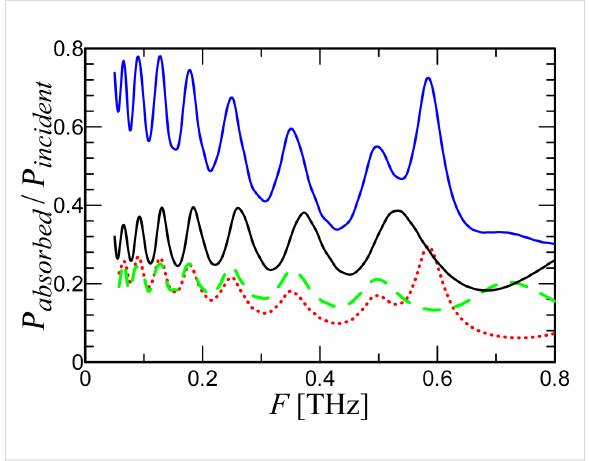
Figure 4: Integral absorbed power for two different cases. Black curve: a single port in an antenna; blue curve: three ports in series. Green dashed line: P absorbed in the central port of the three-port configuration. Red dotted line: P absorbed in port 2 and port